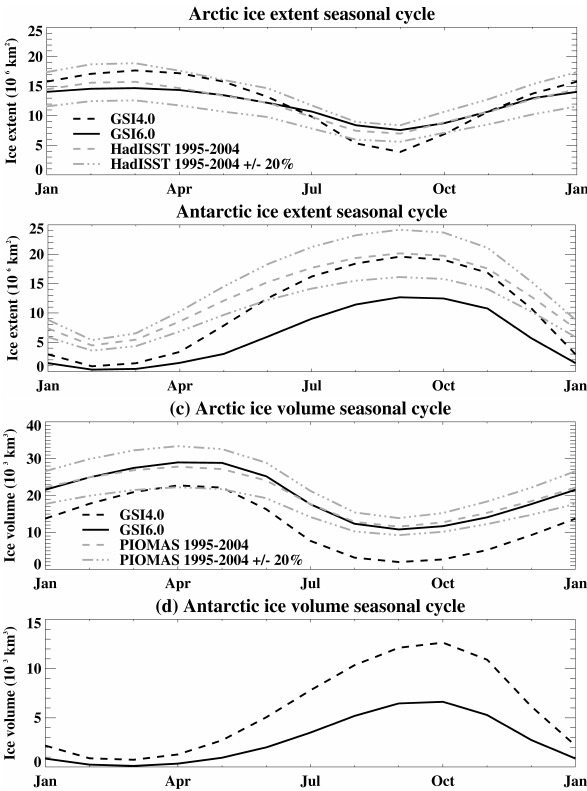
Figure 2. 50-year mean seasonal cycles of sea ice extent and vol- ume in GSI4.0 and GSI6.0, and equivalent 11-year (1995–2004) mean seasonal cycles for the HadISST and PIOMAS data sets.